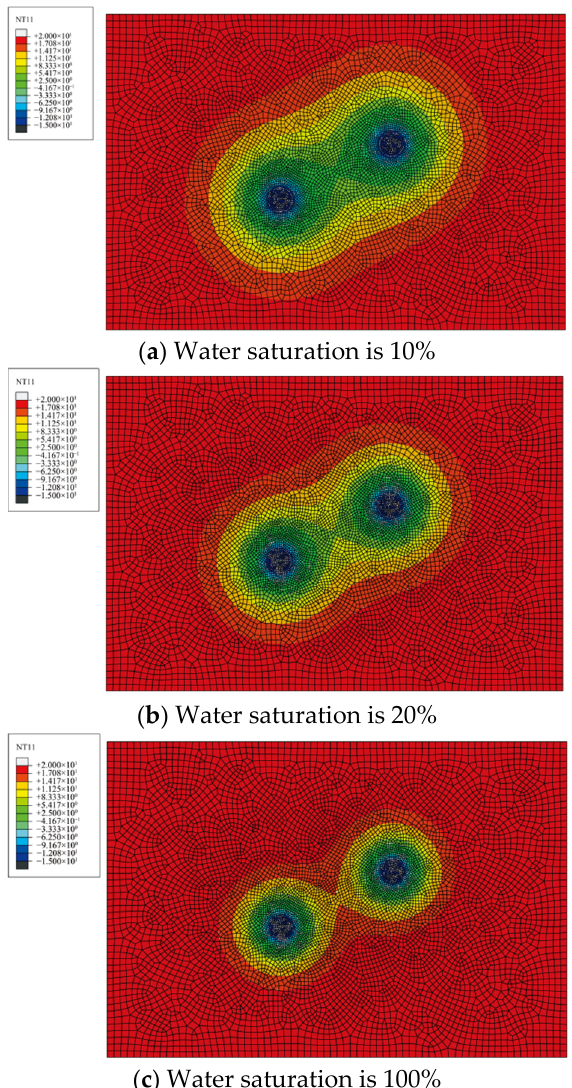
Figure 6. Schematic diagram of heat transfer temperature distribution after 62.7 min under different water saturation conditions.